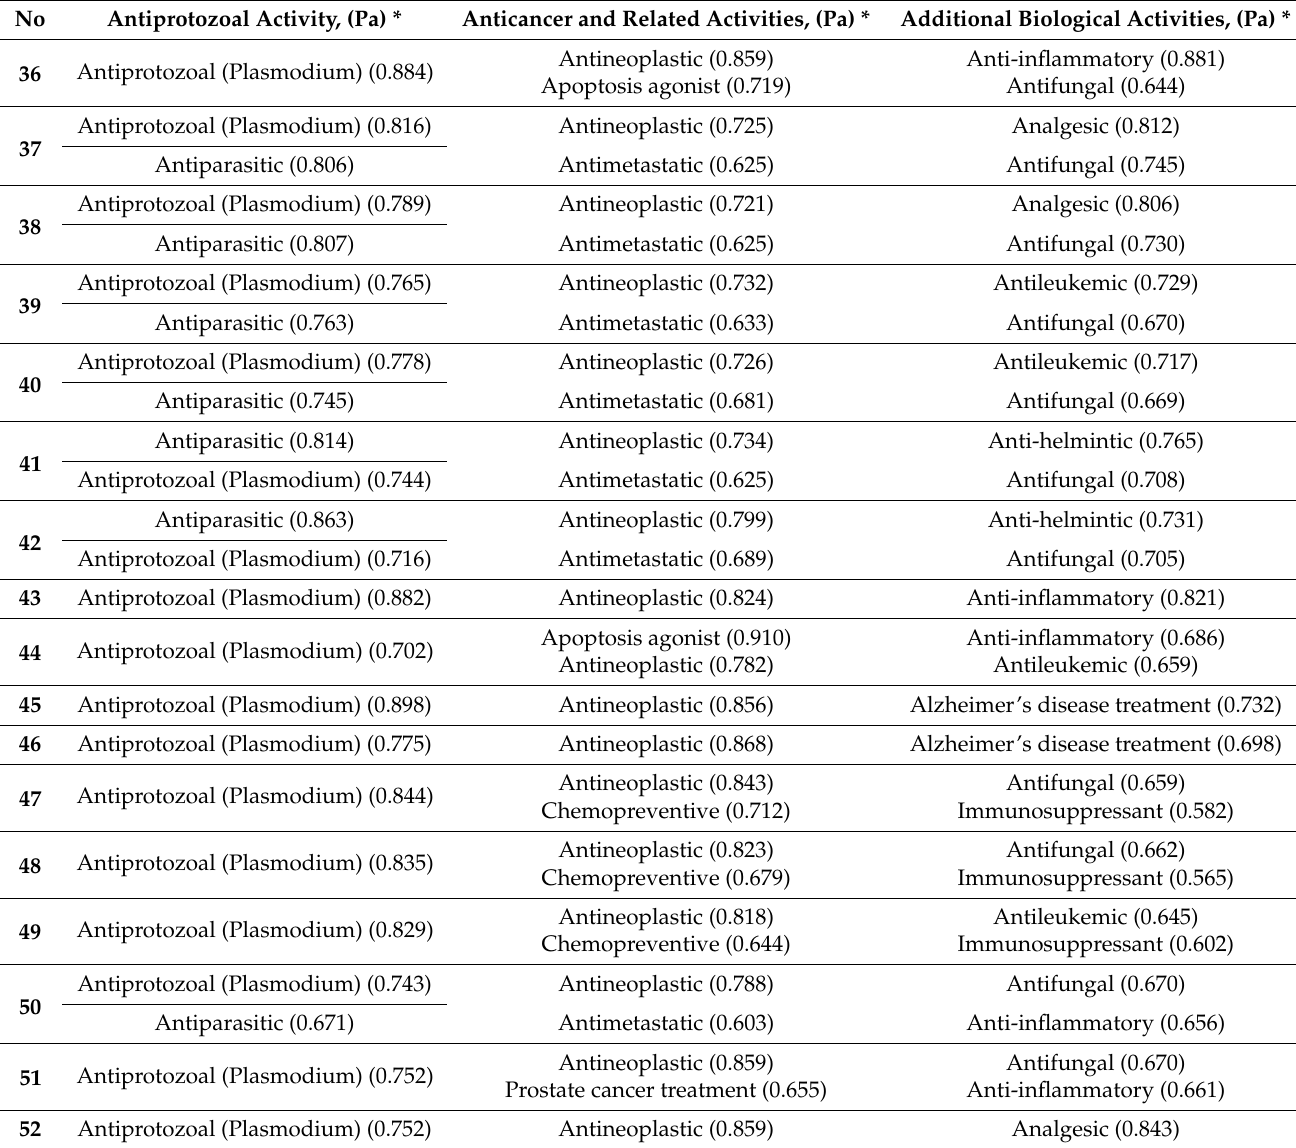
Table 3. Biological activity of natural polycyclic peroxides derived from marine sources and